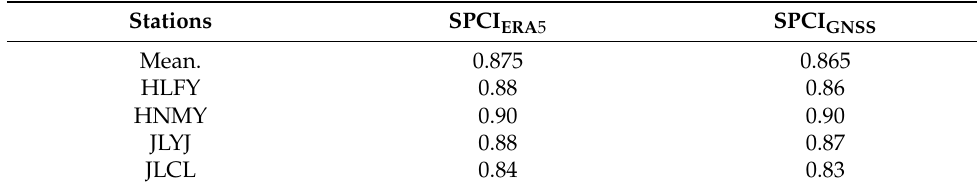
Figure 10. Long-term change of SPEI, SPCI ERA5 and SPCI GNSS at HLFY, HNMY, JLYJ and JLCL stations, respectively over the period of 2012 to 2018. Table 6. Correlation coefficients between SPEI and SPCI ERA5 /SPCI GNSS at HLFY, HNMY, JLYJ and JLCL stations ( p < 0.05) over the period of 2012 to 2018.